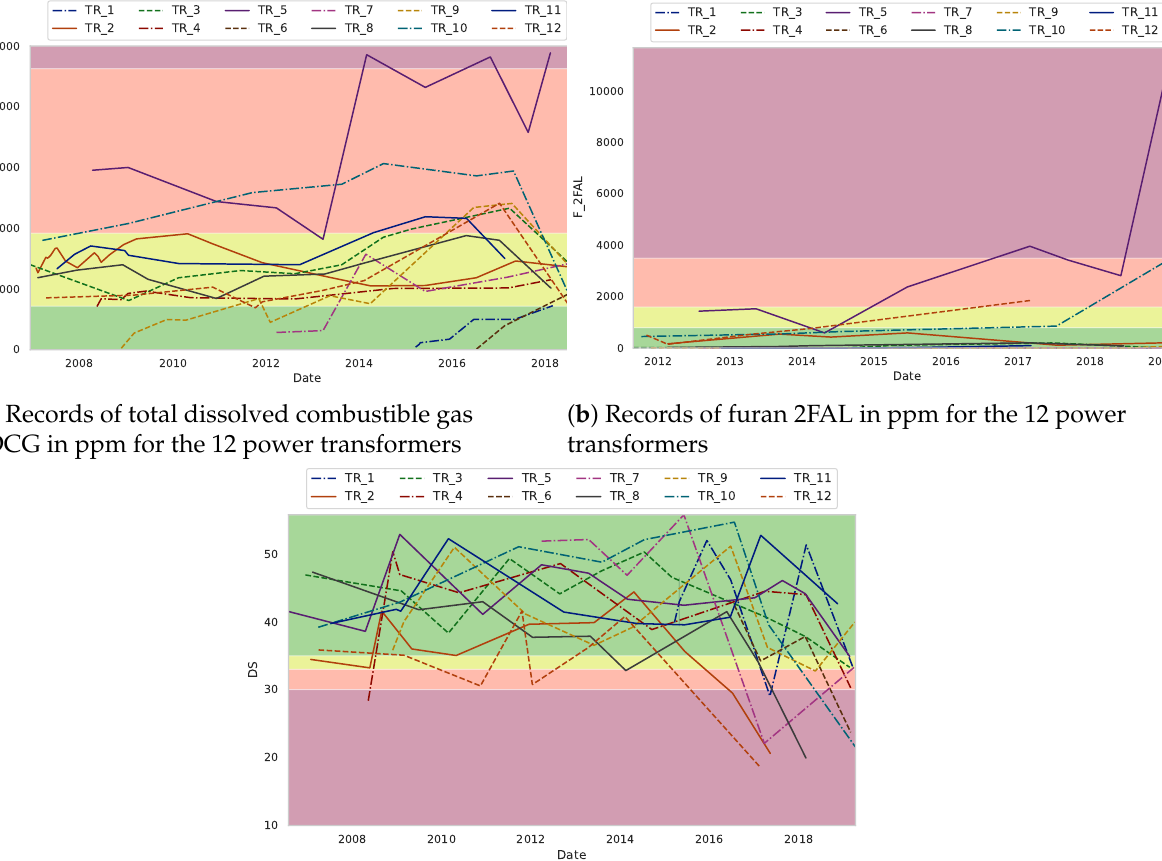
Figure 5. Historical diagnostic test of the power